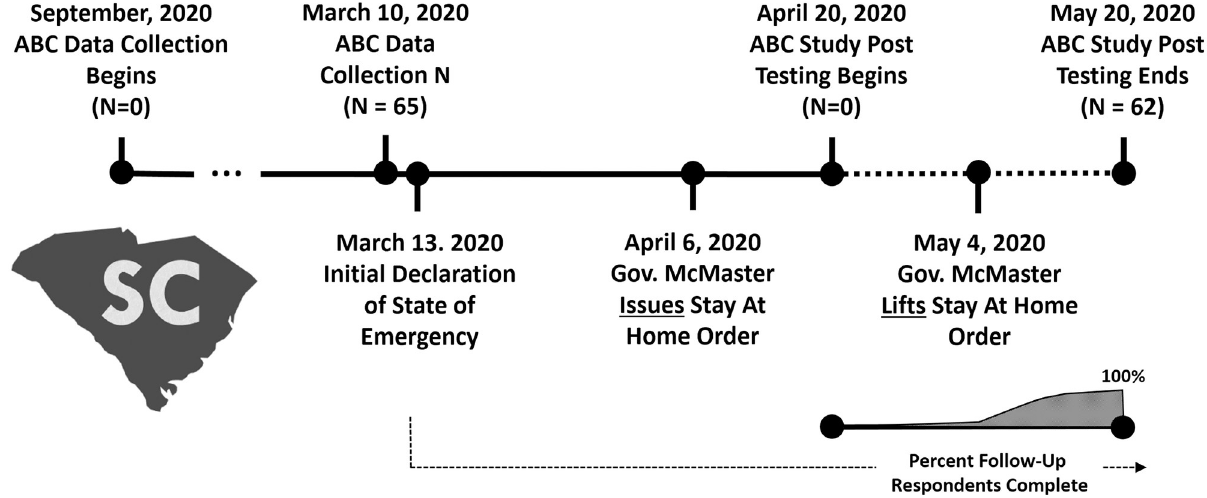
Fig 1. Timeline for recruitment and testing in the current